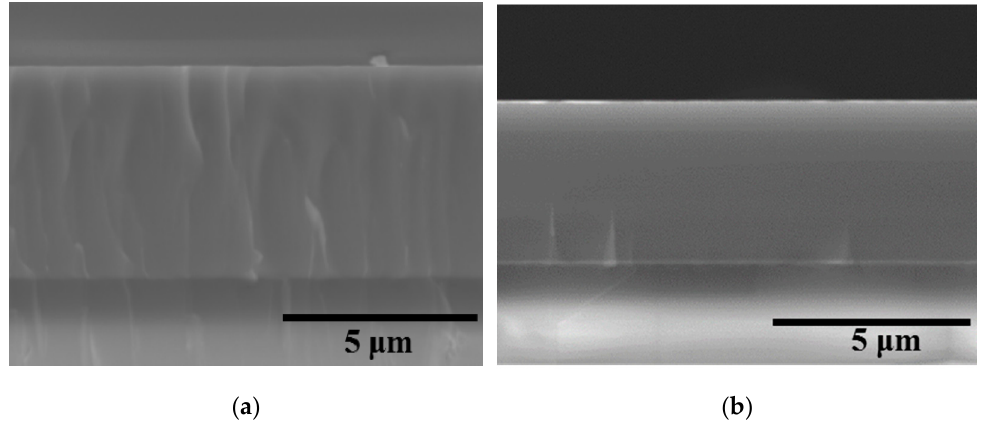
Figure 3. SEM images of Coatings 1A ( a ) and 2N ( b ).